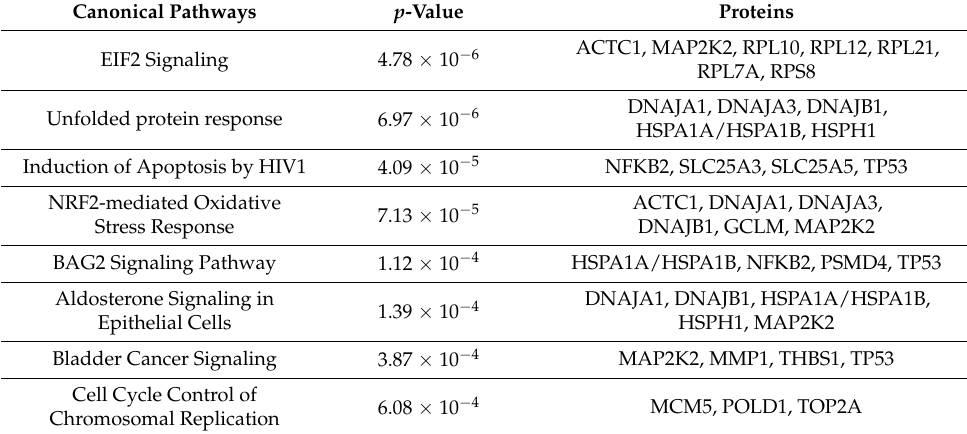
Table 3. Ingenuity canonical pathways associated with the differentially expressed proteins in CuHL1-treated cells.